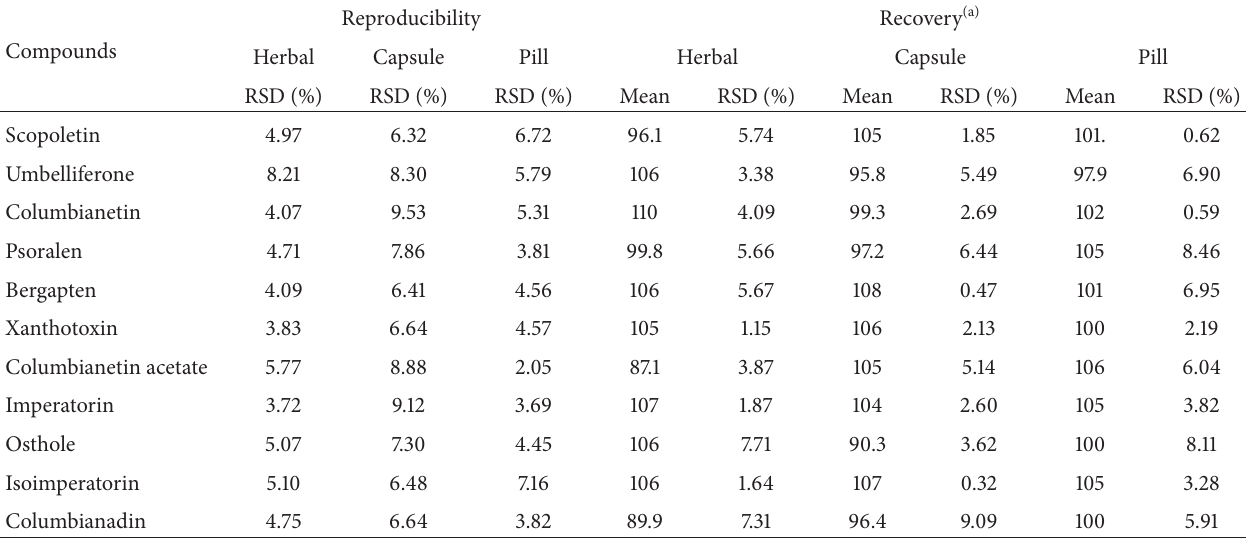
Table 4: Repeatability and recovery of the developed method ( 𝑛 = 6